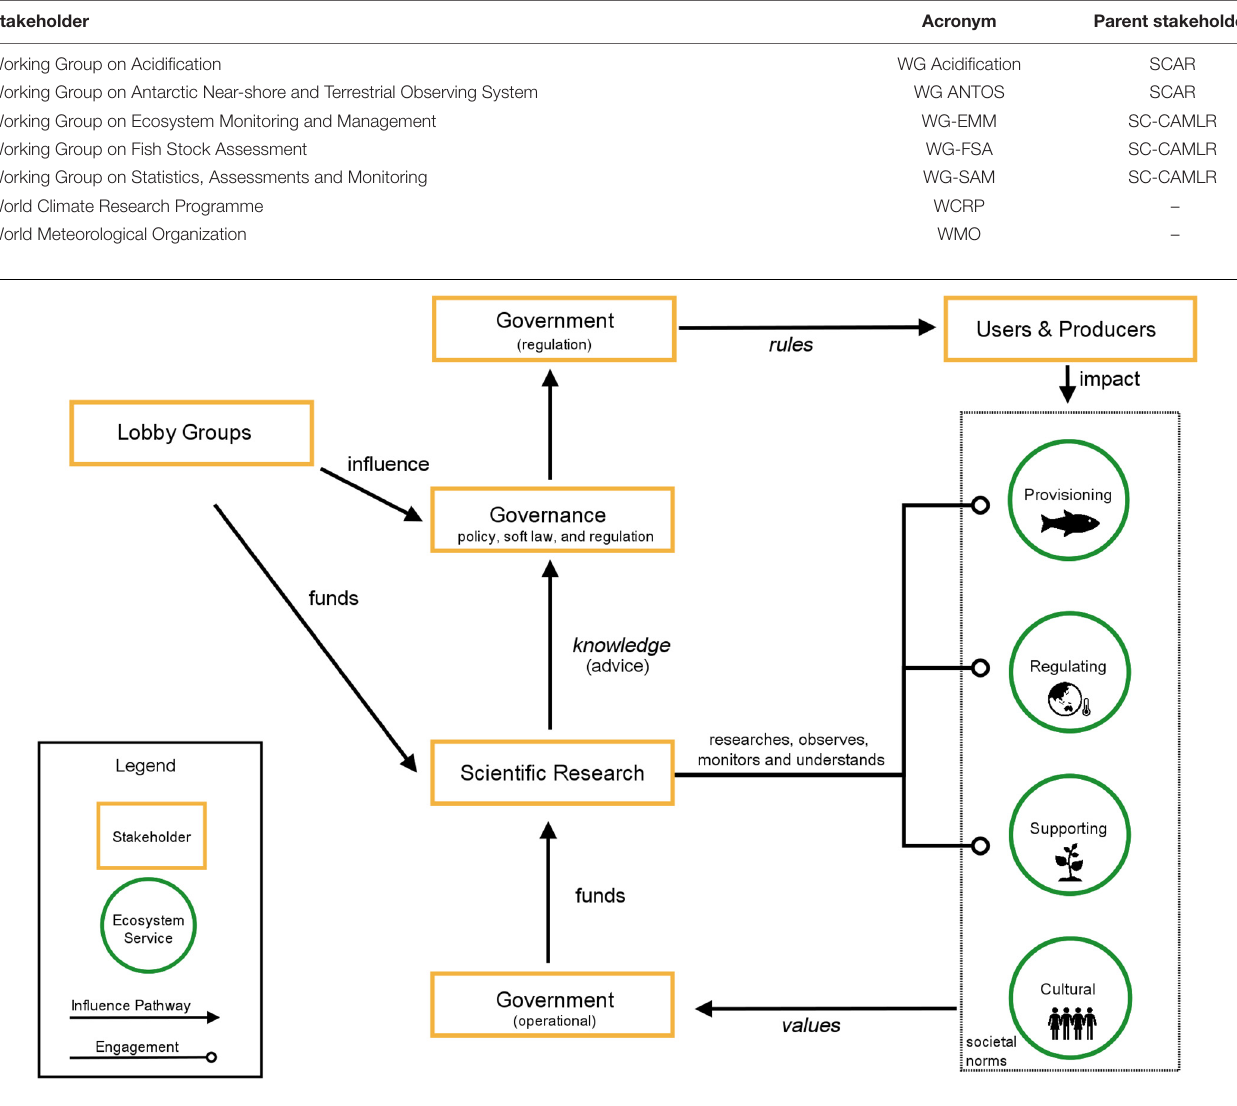
FIGURE 3 | Conceptual representation of decision-making pathways in Southern Ocean ecosystem management, between various stakeholders and ecosystem services. Here, government performs two roles: as a funder and supporter of science, and as a regulator of users and producers. Knowledge, rules and values are italicized to indicate their role as components of the vrk